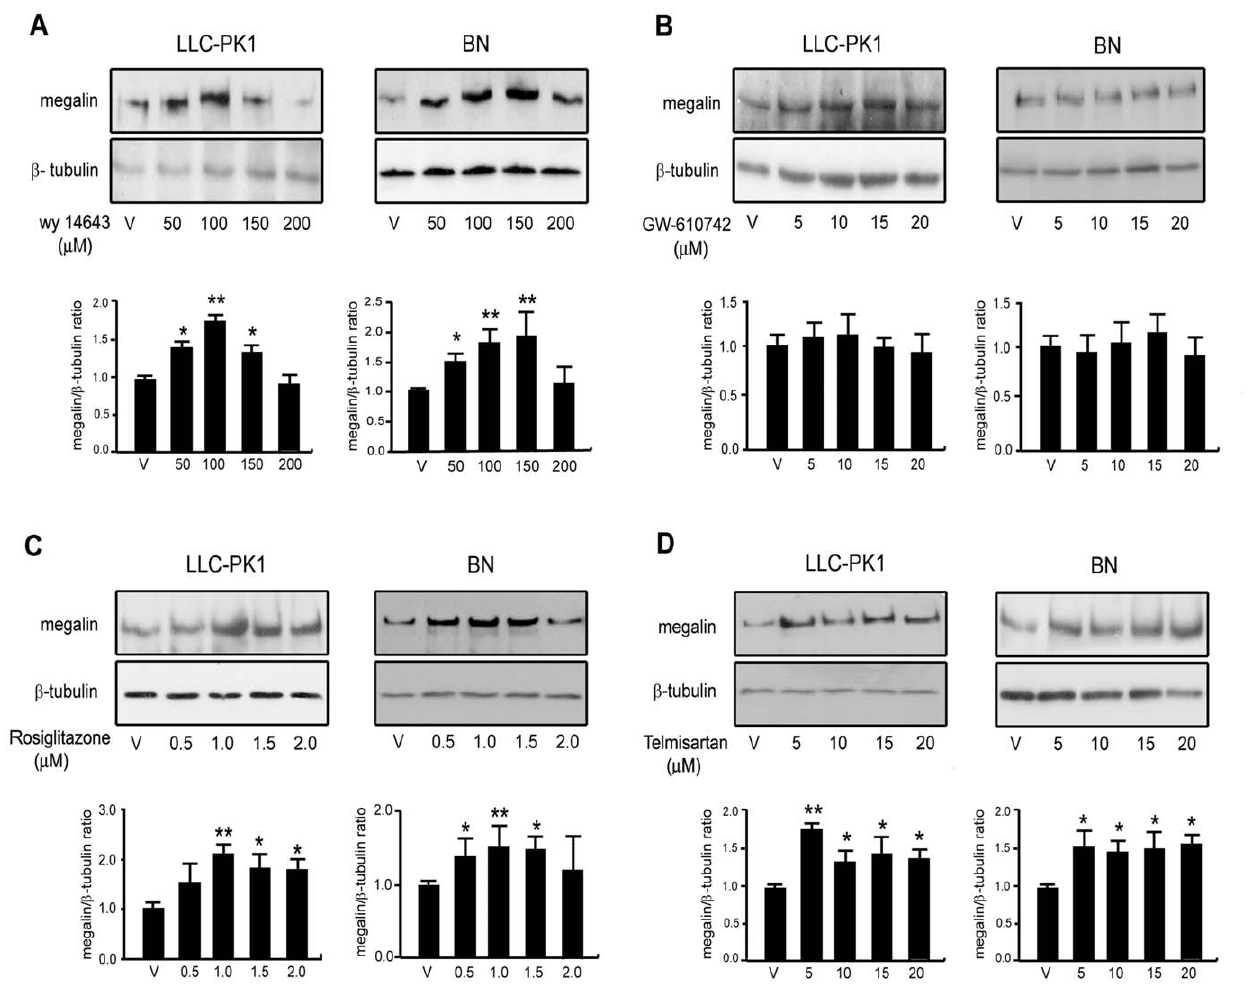
Figure 2. Megalin protein levels are increased in BN and LLC-PK1 cultured cells upon exposure to PPAR a and PPAR c agonists, but not PPAR b agonists. ( a ) BN cells (600,000 cells/well) and LLC-PK1 cells (500,000 cells/well) were treated with different concentrations of the PPAR a agonist WY 14643, ( b ) the PPAR b agonist GW 610742, and the PPAR c agonists ( c ) rosiglitazone and ( d ) telmisartan for 24 h in 0.5% FBS in DMEM. Cells were lysed and the expression of megalin and the loading control, b -tubulin, was determined by western blot. The bands in the blots were quantified by densitometry, and the results were plotted as the ratio of megalin/ b -tubulin for each condition. Statistically significant differences compared to the control (DMSO) are indicated as *P , 0.05, **P ,